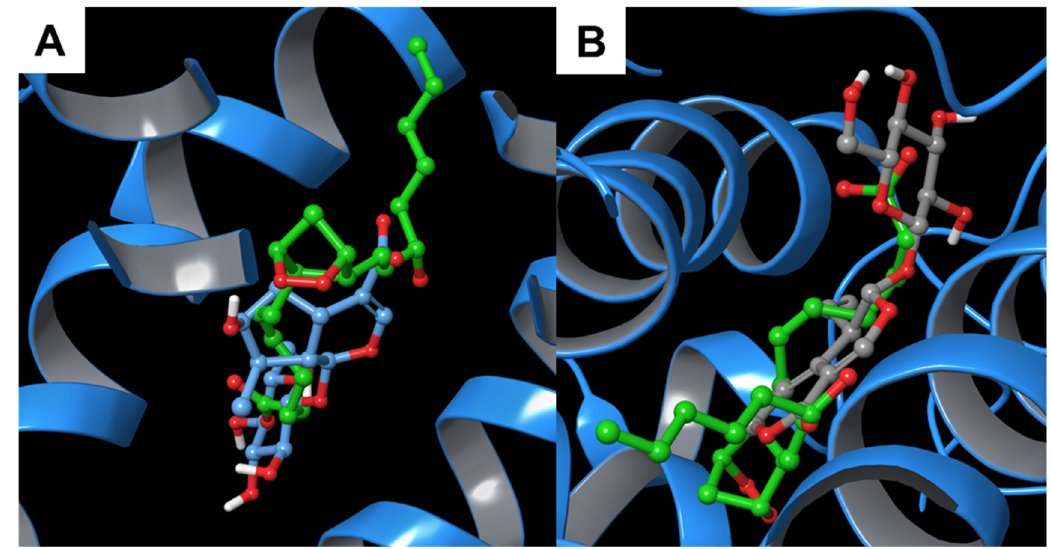
Figure 6. Superimposition between the co-crystallized prostaglandin G 2 and ( A ) 1 and ( B ) 2 inside the binding pocket of COX-2 2 (PDB: 1DDX [44], cyan ribbons).